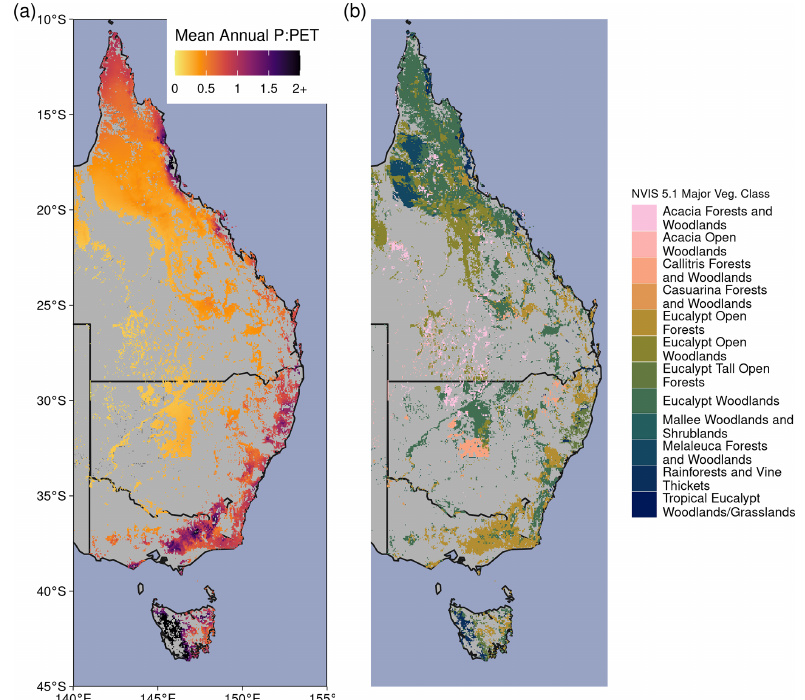
Figure A1. (a) Mean Annual P :PET between 1982–2019. (b) Forest and woodland vegetation classes from version 5.1 of the National Veg- etation Information System (https://www.environment.gov.au/land/native-vegetation/national-vegetation-information-system, last access: 31 March 2021).